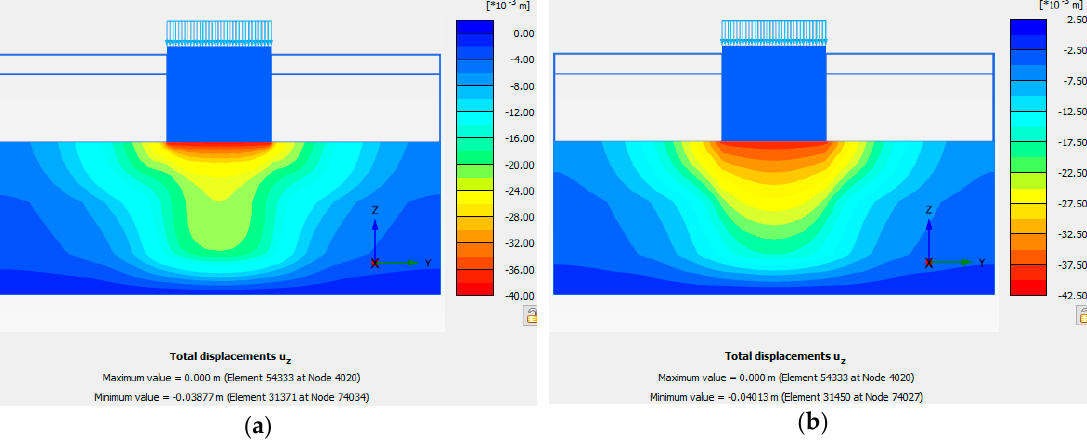
Figure 7. Comparison of vertical deformation of the bottom cushion: ( a ) embedded pile model; ( b ) equivalent reinforcement zone model.